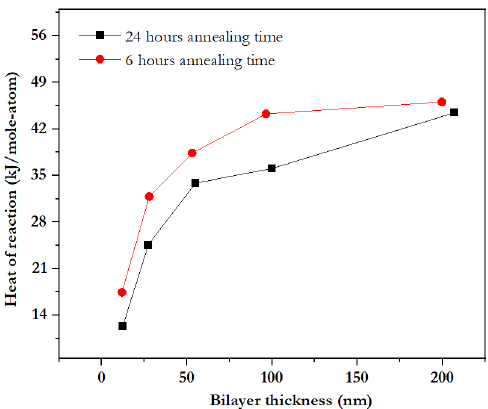
Figure 9. Measured heat of reaction as a function of bilayer thickness at different annealing time [45] .